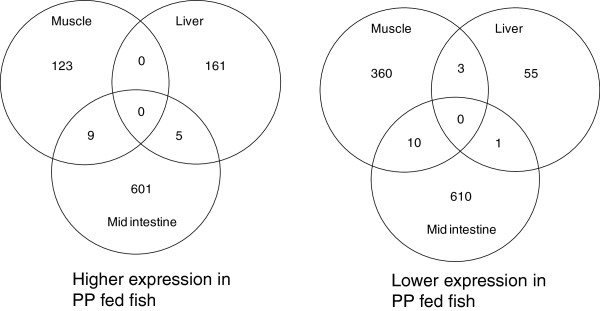
Venn diagram showing numbers of genes identified as expressed at different levels by microarray analysis. Summary of numbers of genes higher and lower expressed. The genes presented are all significantly different in expression (p < 0.05) with >2 fold change in expression.